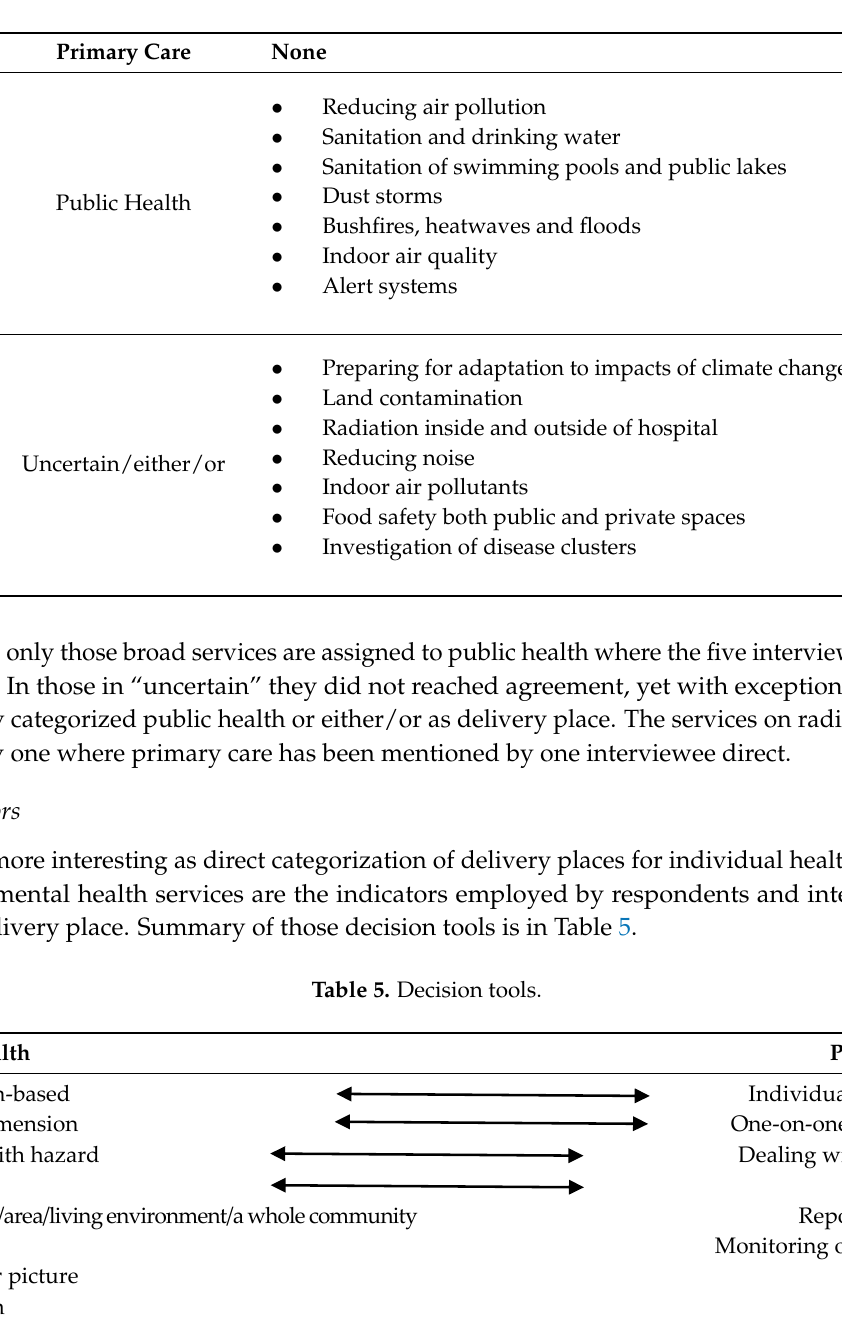
Table 4. Division of environmental health services.